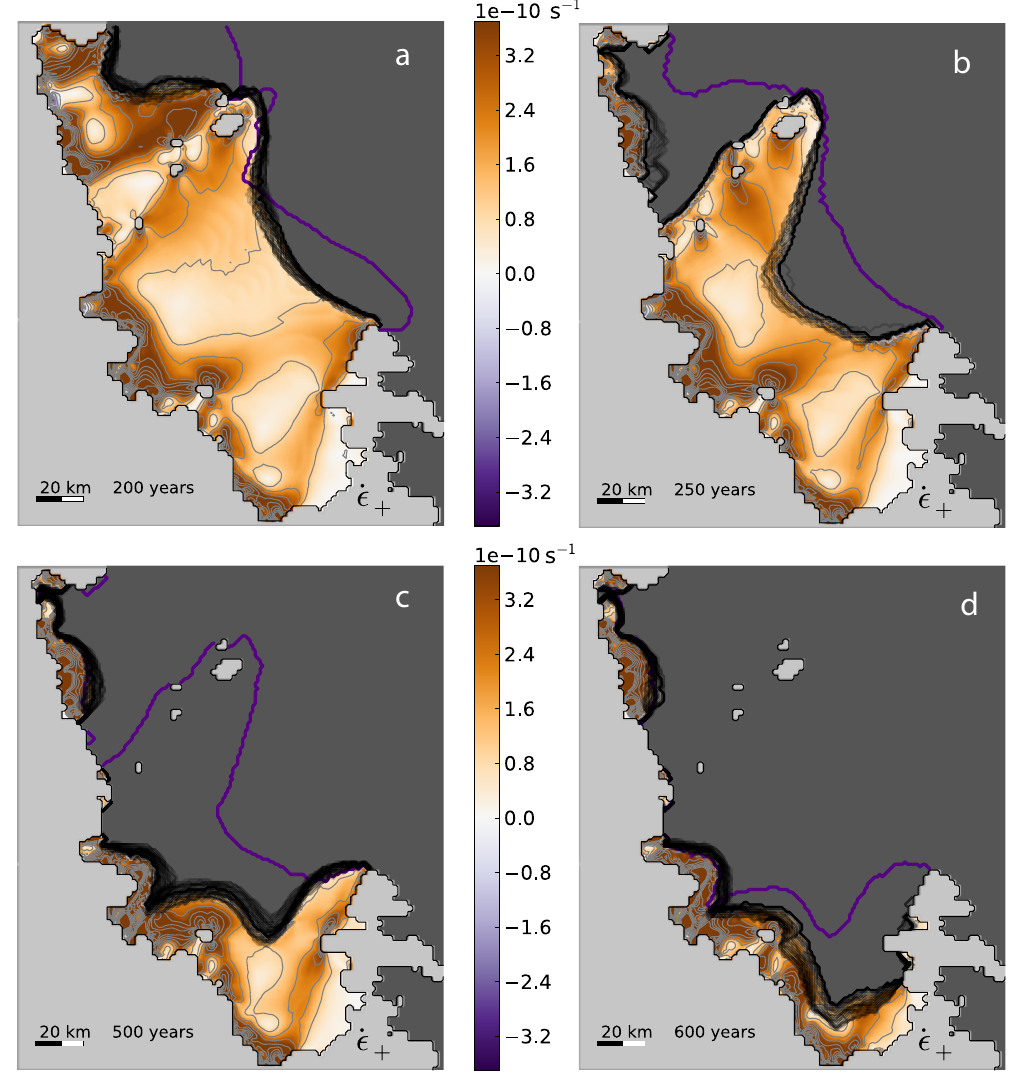
Fig. 7. Simulation of multiple stable calving front position of ice shelves Larsen A and B. Abrupt transitions between the states can be triggered by instantaneous introduction of ice rifts of 2000 m width (two grid cells) for one time step along the purple lines (compare also animation in SI). Shading represents strongest spreading rate ˙ (cid:15) + ≈ ˙ (cid:15) k . Gray lines adjacent to the calving front represents the variability of the front in the equilibrium simulation. Time step for plotted front-front positions is two years. Panel a: Calving front after 100 years of free propagation (purple line) is stabilized by calving rate according to Eq. (1) near the observed 1998 extension (compare Fig. 2). Panel b: Initialization of ice front at the year 1998 positions (purple line) plus rifts in the southern parts of Larsen A, induces a collapse of Larsen A Ice Shelf and a retreat of the Larsen B front to the 1999 position. Panel c: Rift applied along northern margin of Larsen B yields a second stable state of the Larsen B ice front similar to the observed 2002 position. Panel d: Rift applied along southern margins of Larsen B yields third stable state with strongly reduced ice-shelf